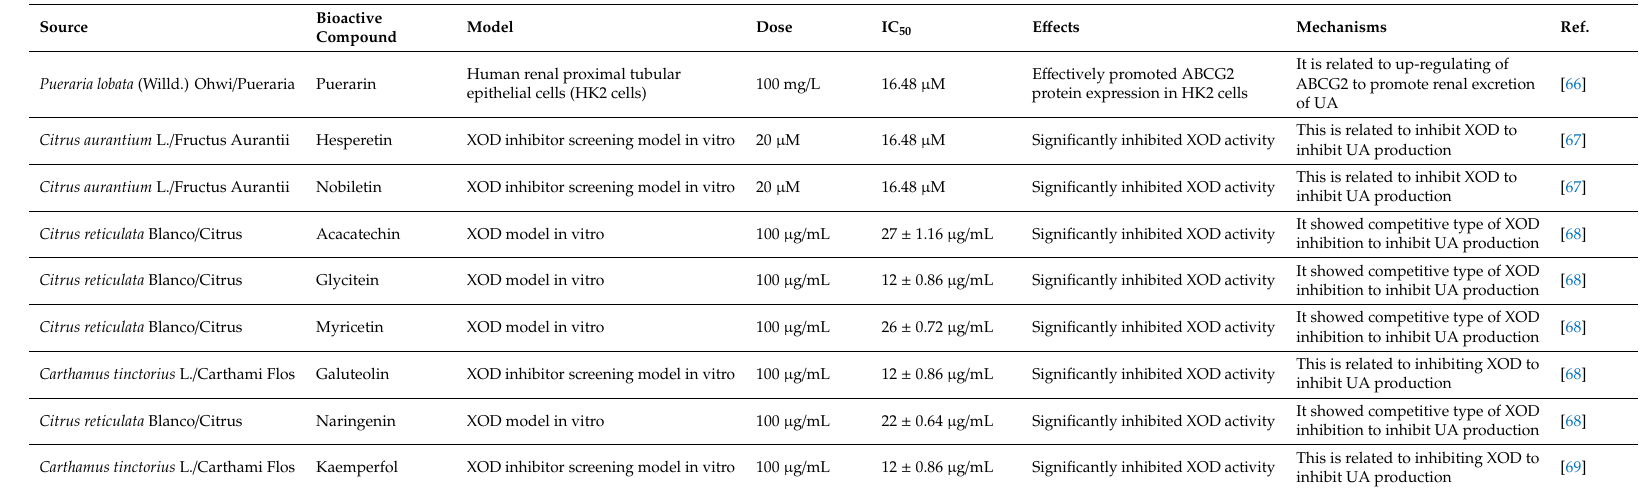
Table 3. In vitro experiment and mechanism of flavonoids bioactive components from plant-based functional foods on